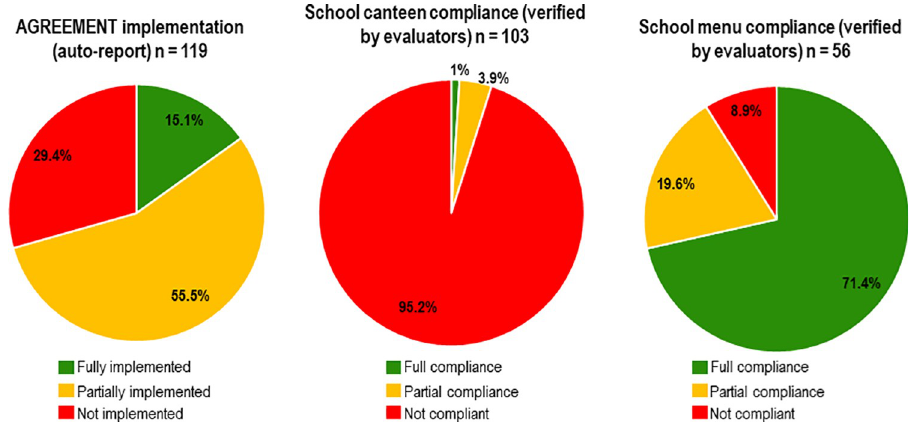
Fig 1. Level of implementation and compliance with the AGREEMENT in elementary schools of